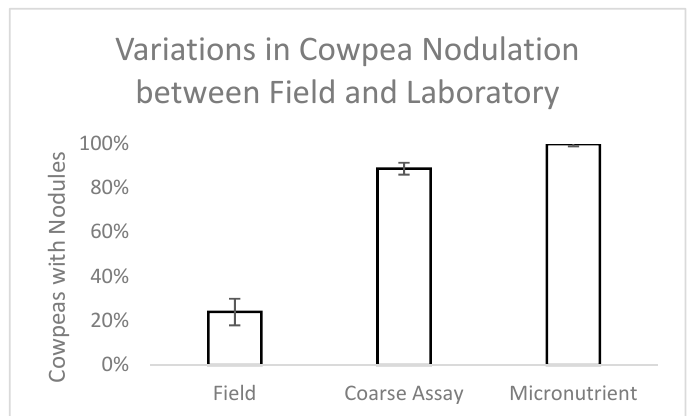
Figure 3. Cowpeas in the coarse assay and micronutrient experiments, inoculated with 1 mL of pipetted rhizobial slurry directly to the seed, showed a substantially higher nodulation rate than cowpeas in the field, inoculated in a more traditional way. The precise inoculation of controlled experiments cannot be replicated in the field, but other ways to bridge the gap and improve field inoculation outcomes must be considered.